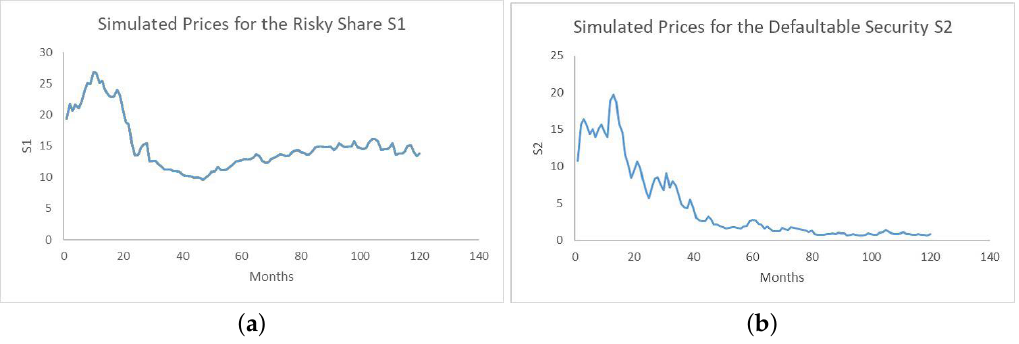
Figure 2. Simulated prices for the risky share S 1 and the defaultable security S 2 . Panel ( a ) for the ordinary share and Panel ( b ) for the defaultable security.